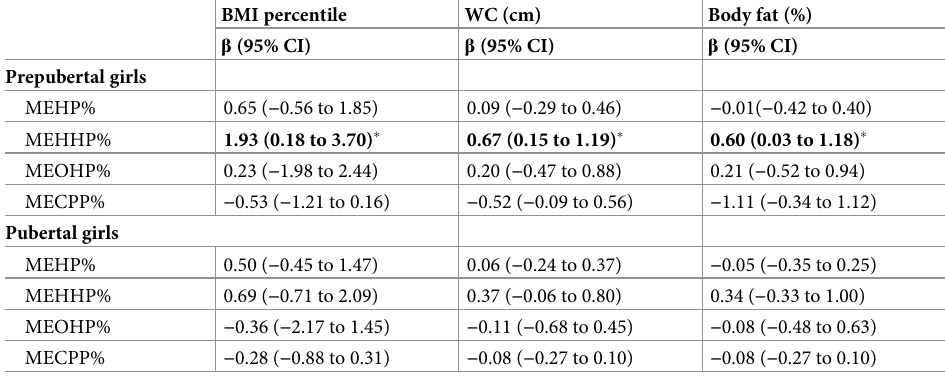
Table 4. Regression analysis of associations between percentage fractions of di(2-ethylhexyl) phthalate (DEHP) metabolites and anthropometric indices (adjusted for age, Tanner stage, and height percentile, � P < 0.05).